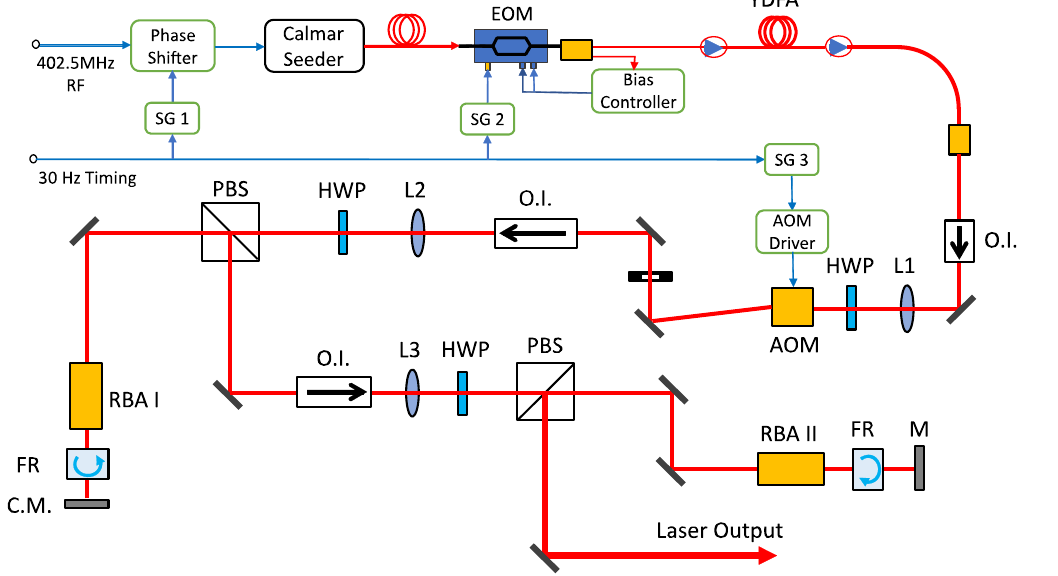
FIG. 4. Schematic of laser system. AOM: acousto-optic modulator; O.I.: optical isolator; L: lens; HWP: half wave plate; M: mirror; C.M.: curved mirror; PBS: polarization beam splitter; FR: Faraday rotator; RBA: diode-pumped Nd:YAG amplifier module; SG1: signal generator for phase shifter control; SG2: signal generator for EOM control; SG3: signal generator for AOM control.